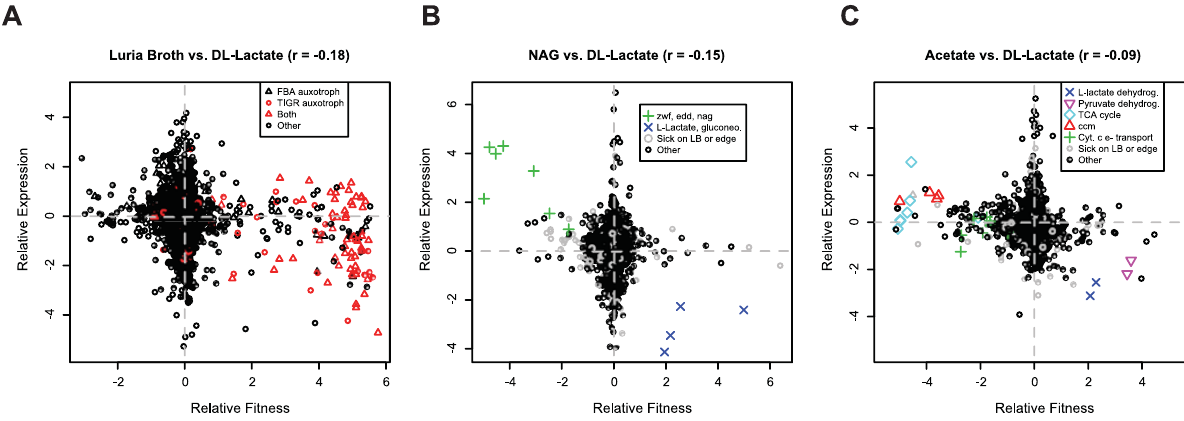
Figure 6. Gene expression and mutant fitness are poorly correlated. (A) Comparison of gene expression and mutant fitness in LB (rich media) versus minimal media with DL-lactate as a carbon source. Relative expression is a comparison of gene expression for wild-type MR-1 in exponential growth in the two conditions. Relative fitness is the difference of pooled fitness values for the two conditions. Both relative fitness and expression values are log 2 ratios. For example, genes on the bottom right of the plot are up-regulated in expression in DL-lactate minimal media relative to LB and are more important for fitness in DL-lactate minimal media than in LB. Therefore, a correlation of -1 would be a perfect correlation between mutant fitness and gene expression. FBA auxotrophs are predicted from flux balance analysis [30]; TIGR auxotrophs are predicted from TIGR functional roles [29]. (B) Same as (A) for minimal media with DL-lactate and N-acetyl-glucosamine (NAG) as carbon sources. Gene codes correspond to edd (SO_2487; phosphogluconate dehydratase), zwf (SO_2489; glucose-6-phosphate 1-dehydrogenase), and nag ( nagP (SO_3503), nagA (SO_3505), nagB-II (SO_3506), nagK-I (SO_3507), and nagR (SO_3516)). The NAG genes were annotated by Osterman and colleagues [80]. Sick on LB or edge indicates if a gene is sick on LB (which means that the gene is likely sick in many conditions) or insertions for that gene are only on the edge (not within the central 5–80% portion of the protein). (C) Same as (A) for minimal media with DL-lactate and acetate as carbon sources. Gene codes correspond to L-lactate dehydrogenase (SO_1518:SO_1519), pyruvate dehydrogenase (SO_0424:SO_0425), ccm – cytochrome c maturation (SO_0259:SO_0268), cytochrome c electron transport genes (SO_2357:SO_2364; SO_0608:SO_0610), and TCA cycle and related genes (SO_0770, SO_1483:SO_1484, SO_2339:SO_2341,